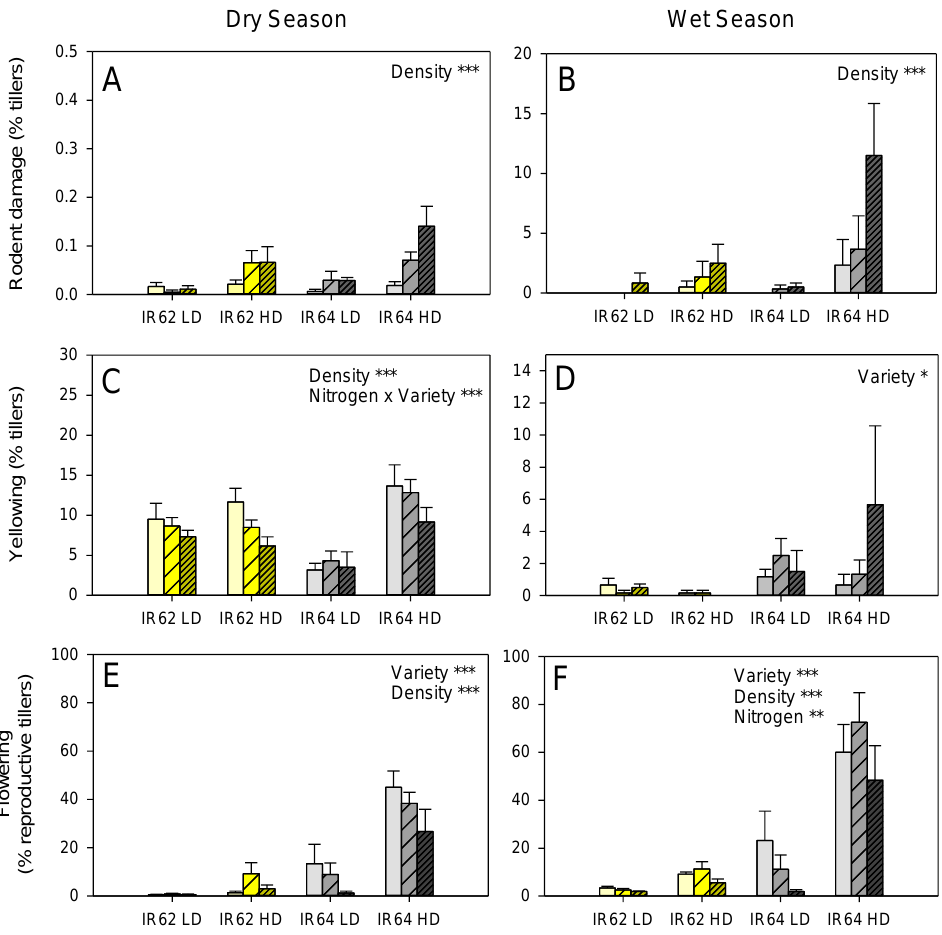
Figure 7. Rodent damage (i.e., % cut tillers: A,B ), the percentage of tillers that were yellowing ( C,D ) and the percentage of reproductive tillers that were flowering at the time sampling was conducted ( E,F ) in plots with resistant (IR62: yellow bars) and susceptible (IR64: grey bars) rice transplanted at low (LD) and high (HD) densities under varying nitrogen fertilizer treatments. Nitrogen was applied at 0 Kg ha −1 (open bars), 60 Kg ha −1 (hatched bars), and 150 Kg ha −1 (densely-hatched bars). Factors that significantly affected each parameter are presented with significance levels as * = p ≤ 0.05, ** = p ≤ 0.01 and *** = p ≤ 0.005. Sampling was conducted during the dry ( A,C,E ) and wet ( B,D,F ) seasons. Standard errors are indicated ( N = 6).